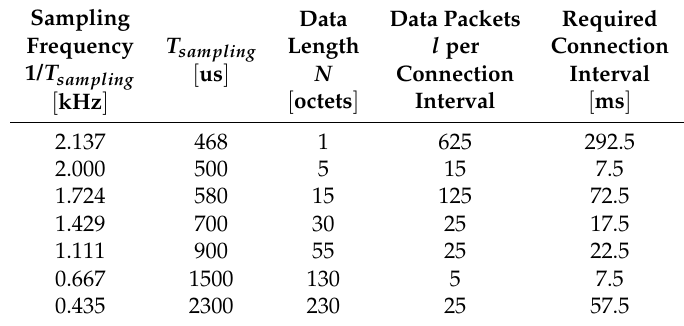
Table 1. Different sets of sampling parameters for sending data packets equally spaced in time with T sampling < 7.5 ms.